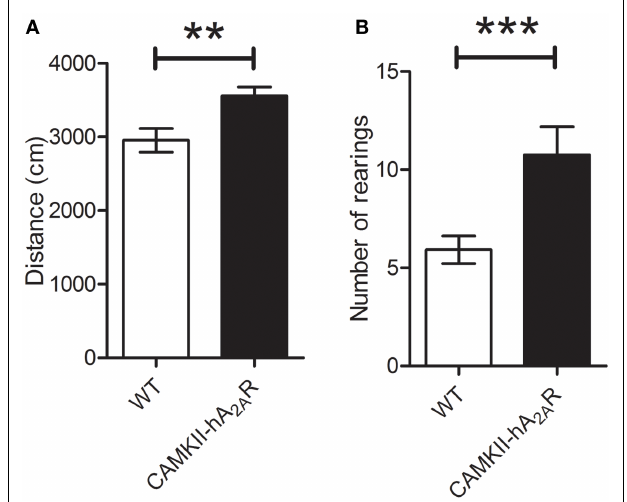
FIGURE 3 | Open-field test . (A) Distance covered in centimeter. (B) Number of rearings – results are expressed as mean ± SEM.